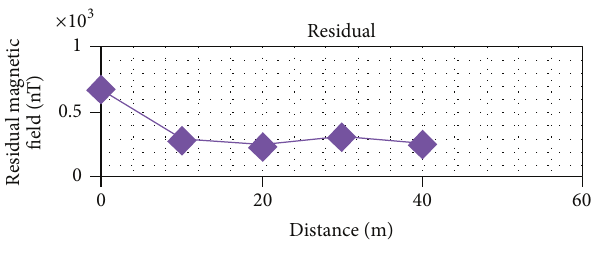
Figure 12: Profile 9.